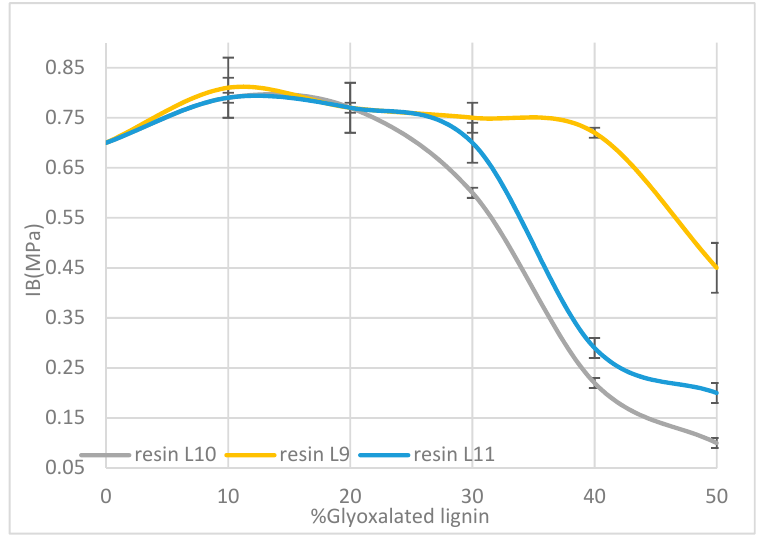
Figure 6. Evolution of the internal bonding (IB) strength of the particleboards as a function of the glyoxatated organosolv lignin content in the formulations.